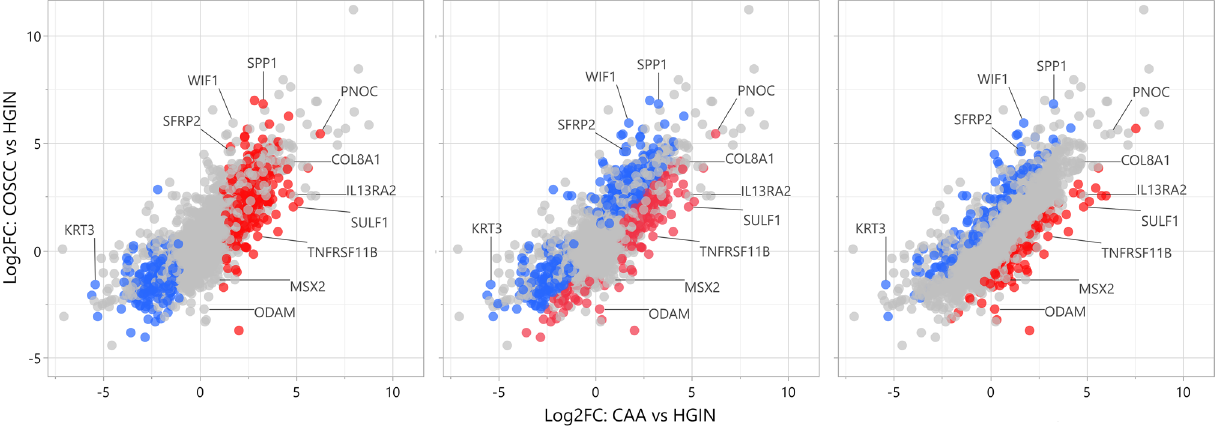
Figure 1. Scatterplots showing patterns of differential gene expression in CAA and COSCC according to log2- fold change (Log2FC) values relative to HGIN. Each point, regardless of color, corresponds to an individual gene; only expressed genes are depicted. The eleven labeled genes correspond to those that were used for qPCR validation assays. The three panels differ only by coloration of individual genes. Panel ( A ) shows 783 genes that were found to be significantly upregulated (red) and 412 that were downregulated (blue) in CAA compared to HGIN when applying stringent differential expression criteria. The colored (red and blue) points in panel B depict 1507 genes that were found to be differentially expressed in one or both tumors when compared to HGIN (i.e., CAA vs HGIN or COSCC vs HGIN), with red points corresponding to those that were upregulated in CAA versus COSCC, and blue points corresponding to those that were downregulated in CAA versus COSCC. Panel C shows 142 genes that were significantly upregulated (red) and 272 genes that were significantly downregulated (blue) in CAA versus COSCC regardless of how they compared to HGIN. Abbreviations: HGIN healthy gingiva, OSCC canine oral squamous cell carcinoma, CAA canine acanthomatous